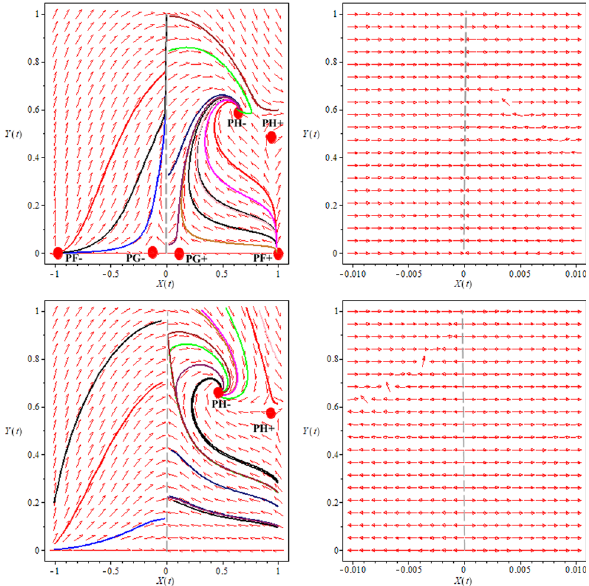
Fig. 6 Phase portrait of the autonomous system of ODE (21) and (22) for the case α = β and the specific choice (β = − 0 . 01 ,λ = 2 ) - top panels- and (β = 0 . − 5 ,λ = 2 . 5 ) - bottom panels-. Here the gray line denotes the separatrix X = 0 which exists whenever Y (cid:2)= 1 and divides the regions where the kinetic term of the scalar field is positive or negative. It can be seen that the trajectories end at it for α/( 1 − α + β) < 0 or depart from it if α/( 1 − α + β) > 0. Due to an optical illusion one could assume that some trajectories can cross the separatrix,andthenthebehaviorofthetrajectoriesaroundtheseparatrix is shown in the right-hand side. In the first scenario, Point F + and Point F − denoteunstablenodes,Point G + andPoint G − correspondtosaddle nodes, Point H + describes an accelerated stable solution, which can be of cosmological interest. For the latter scenario, Point F + , Point F − , Point G + and Point G − vanish, leaving Point H + describing a saddle node and Point H − which is associated to a stable spiral. This scenario is